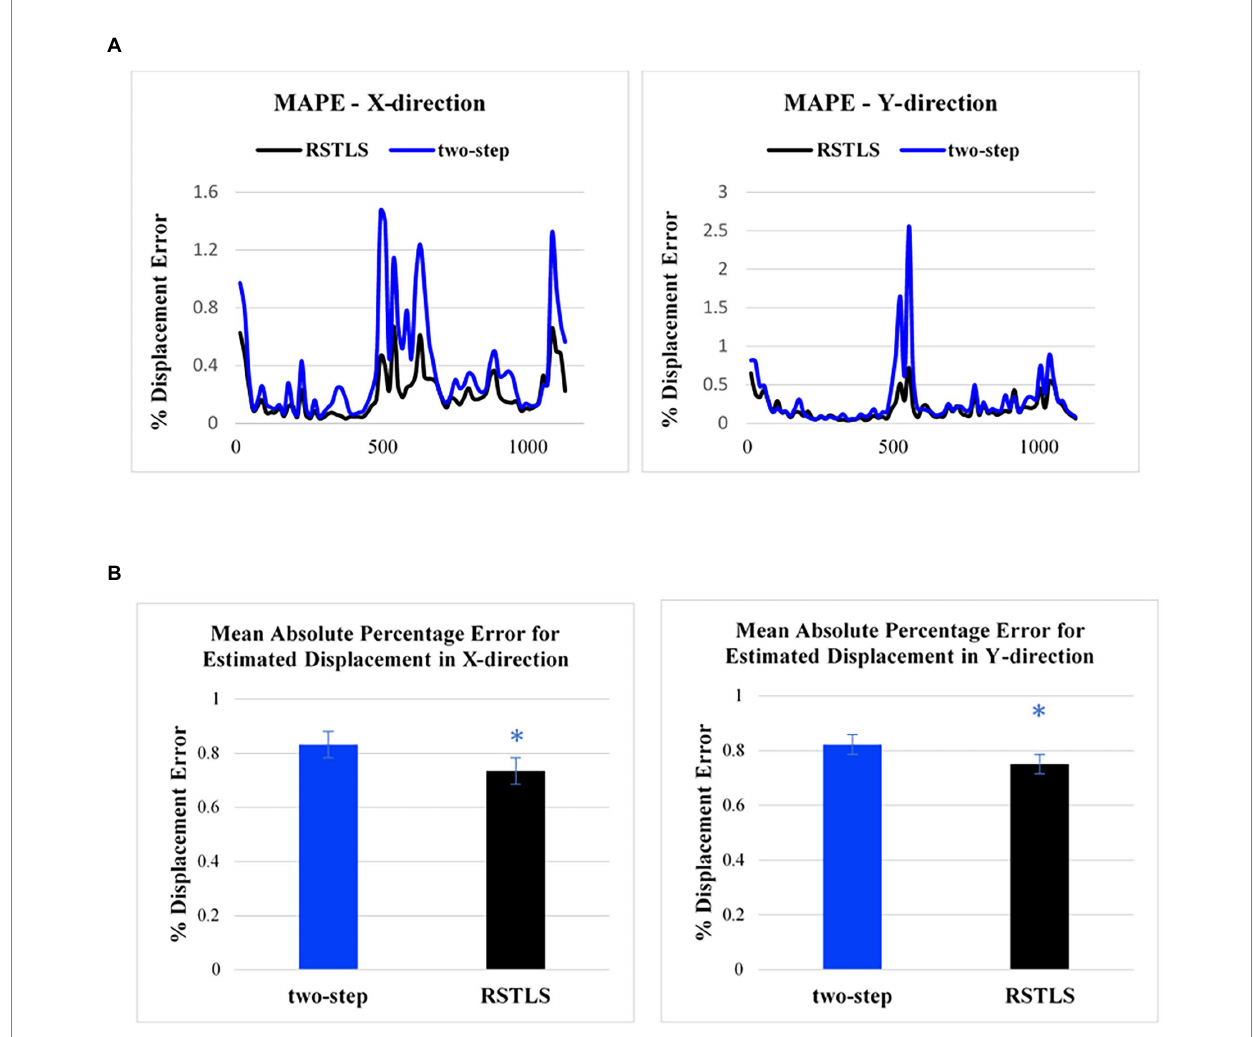
FIGURE 3 (A) Examples of the mean absolute percentage error for the two-step and RSTLS methods as a function of time in the cardiac cycle for displacement measured in the x- and y-directions. The greatest percent of errors appear in early systole and early and late diastole. (B) Comparison of mean absolute percentage error for healthy subjects averaged over time. The graphs are plotted based on 182 slices from 71 volunteers. Error bars represent standard error. * p <